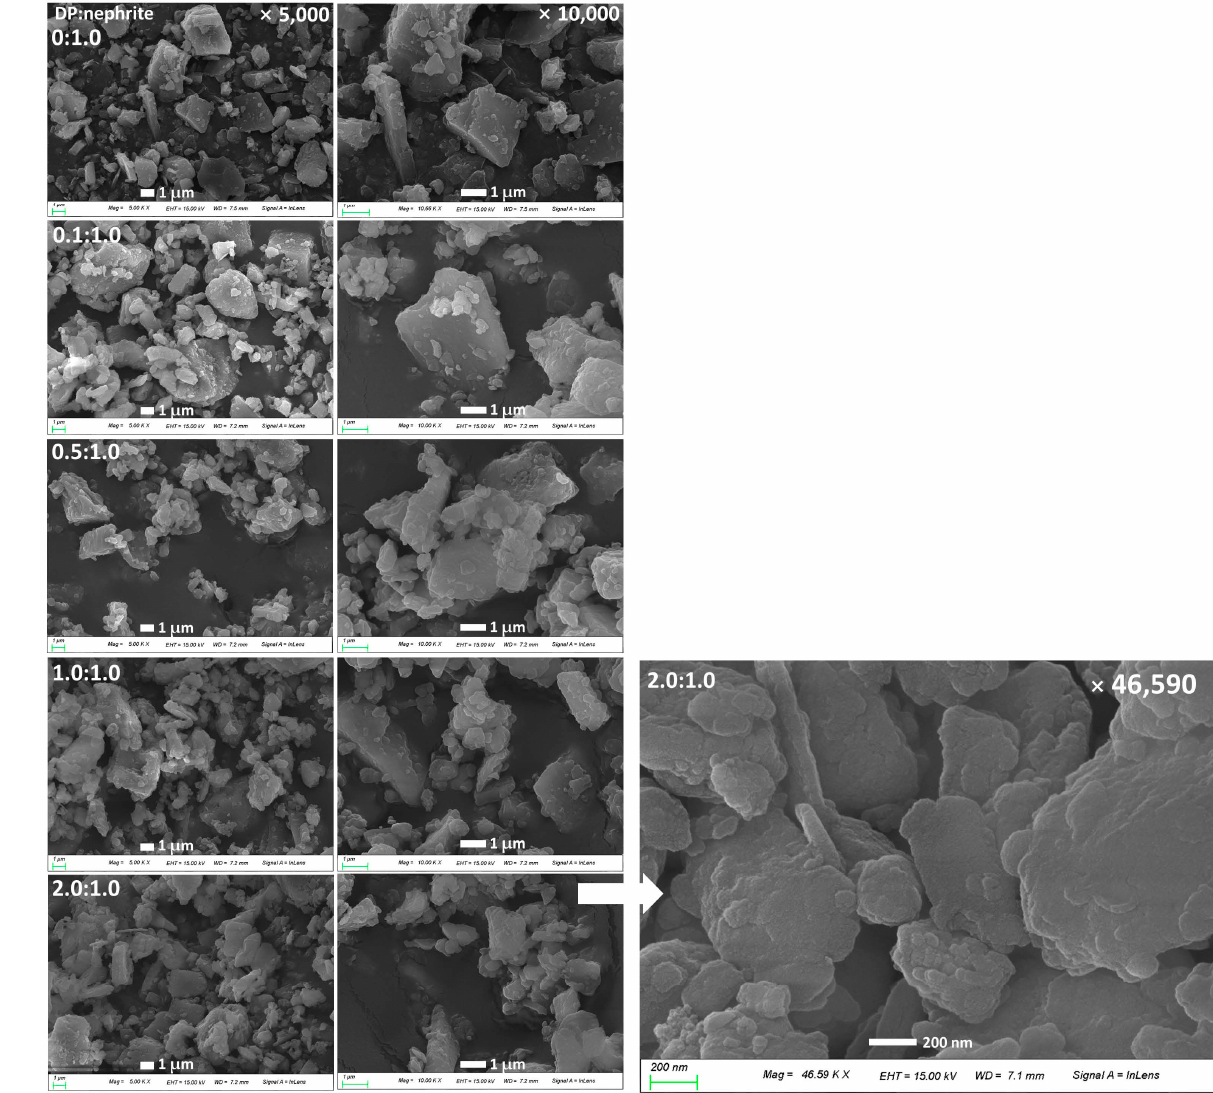
Figure 2. Morphological observation of nephrite and PDA-coated nephrite composites.